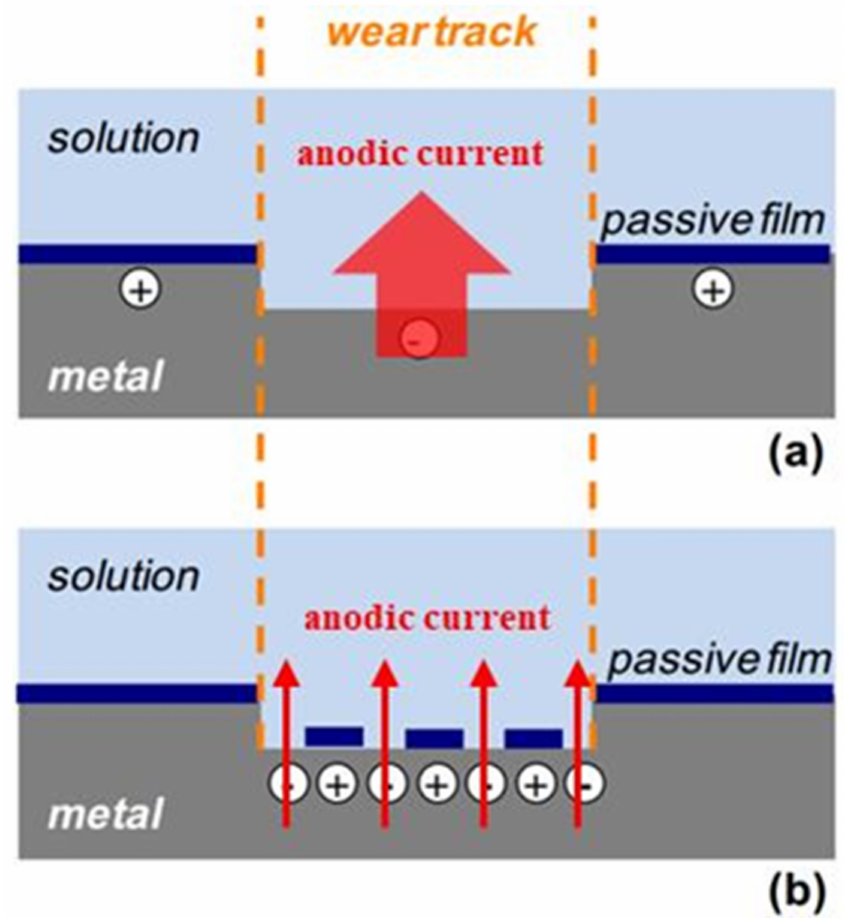
Figure 13. Schematic diagrams of the repassivation mechanism for ( a ) the metal substrate in direct contact with the solution when the passive film is removed by friction and ( b ) passive film growth in the initial period of